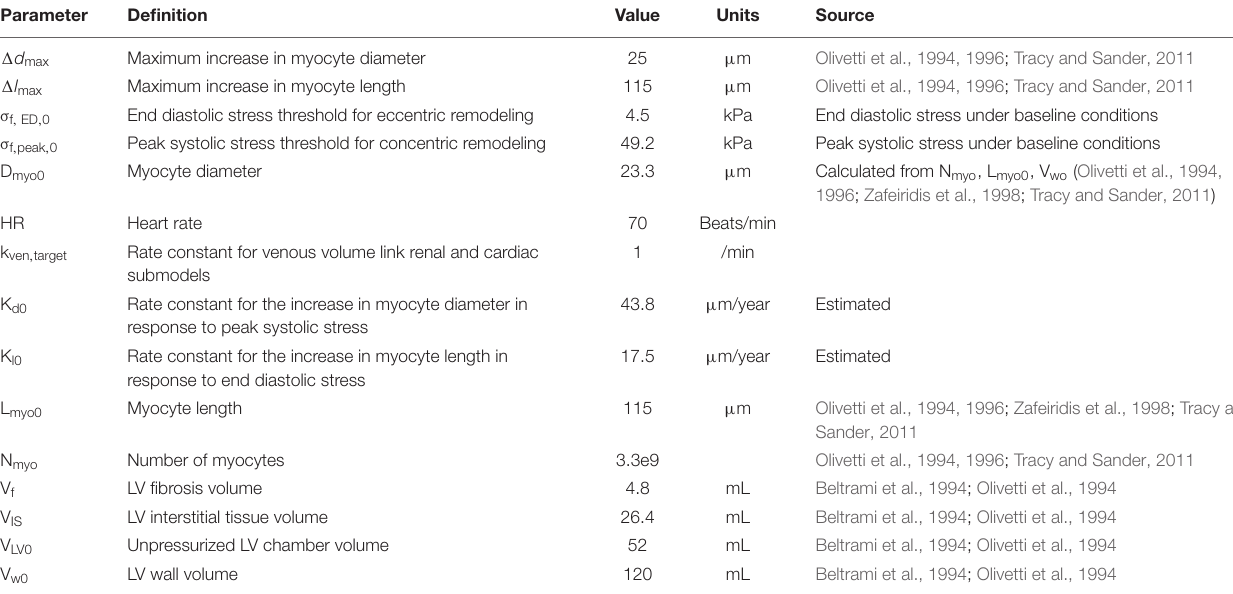
TABLE 1 | Cardiac model parameters.